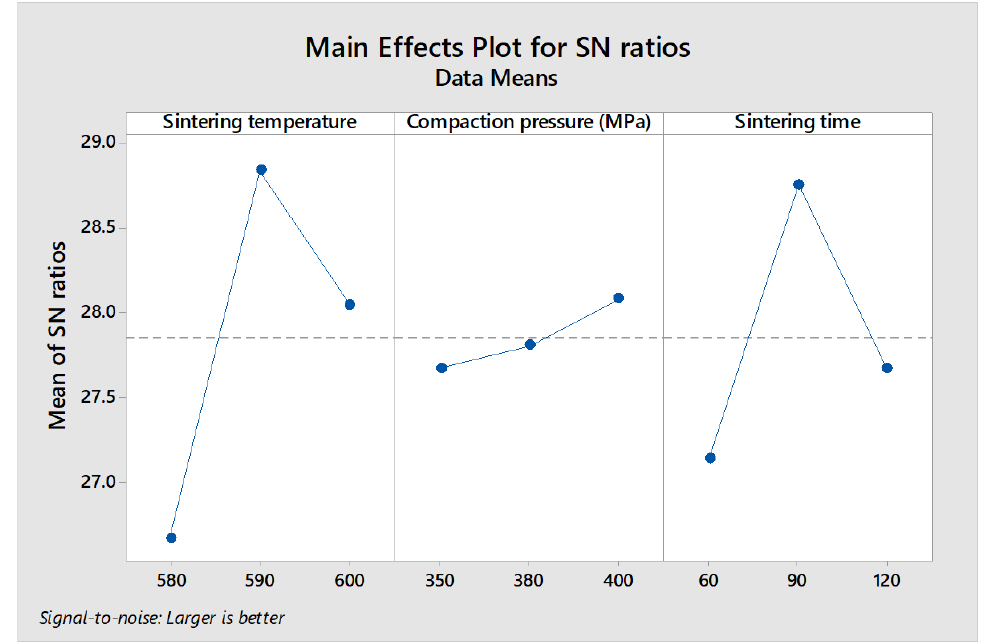
Figure 8. S/N ratio response curve of plateau stress.